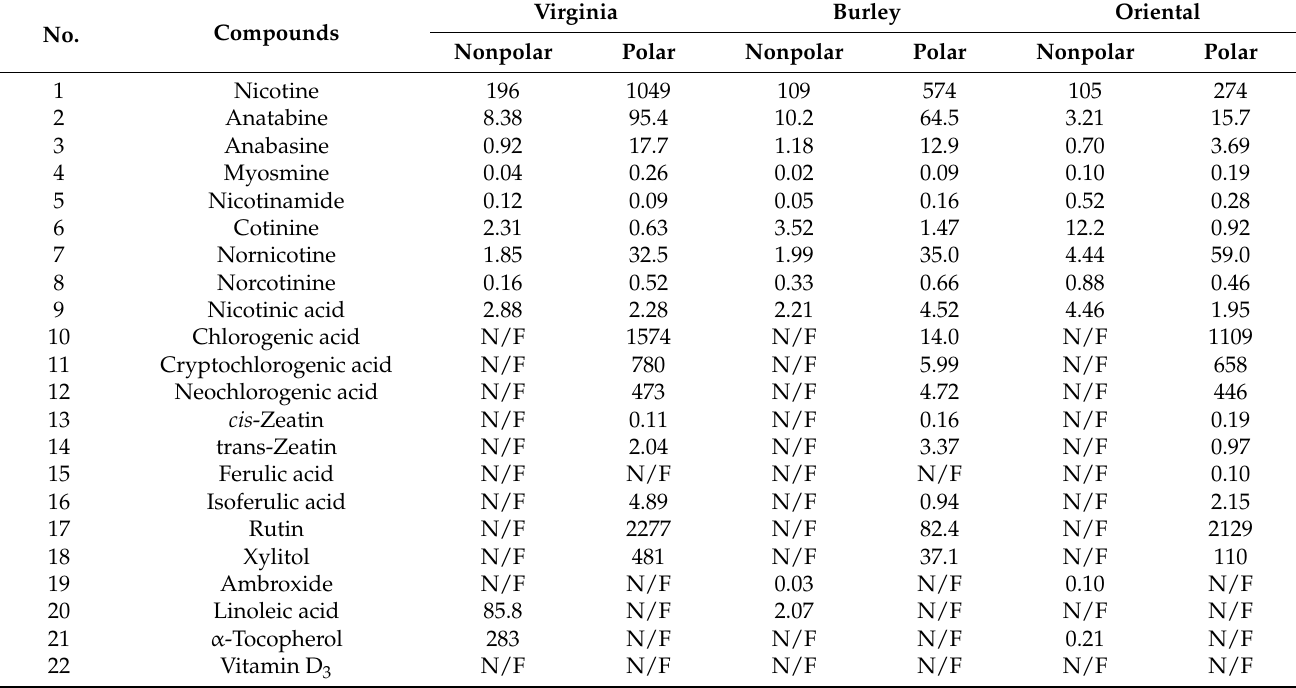
Table 3. Total determined contents of 22 compounds of interest in the nonpolar and polar fractions of the three varieties: Virginia, Burley, and Oriental ( µ g/g dry plant